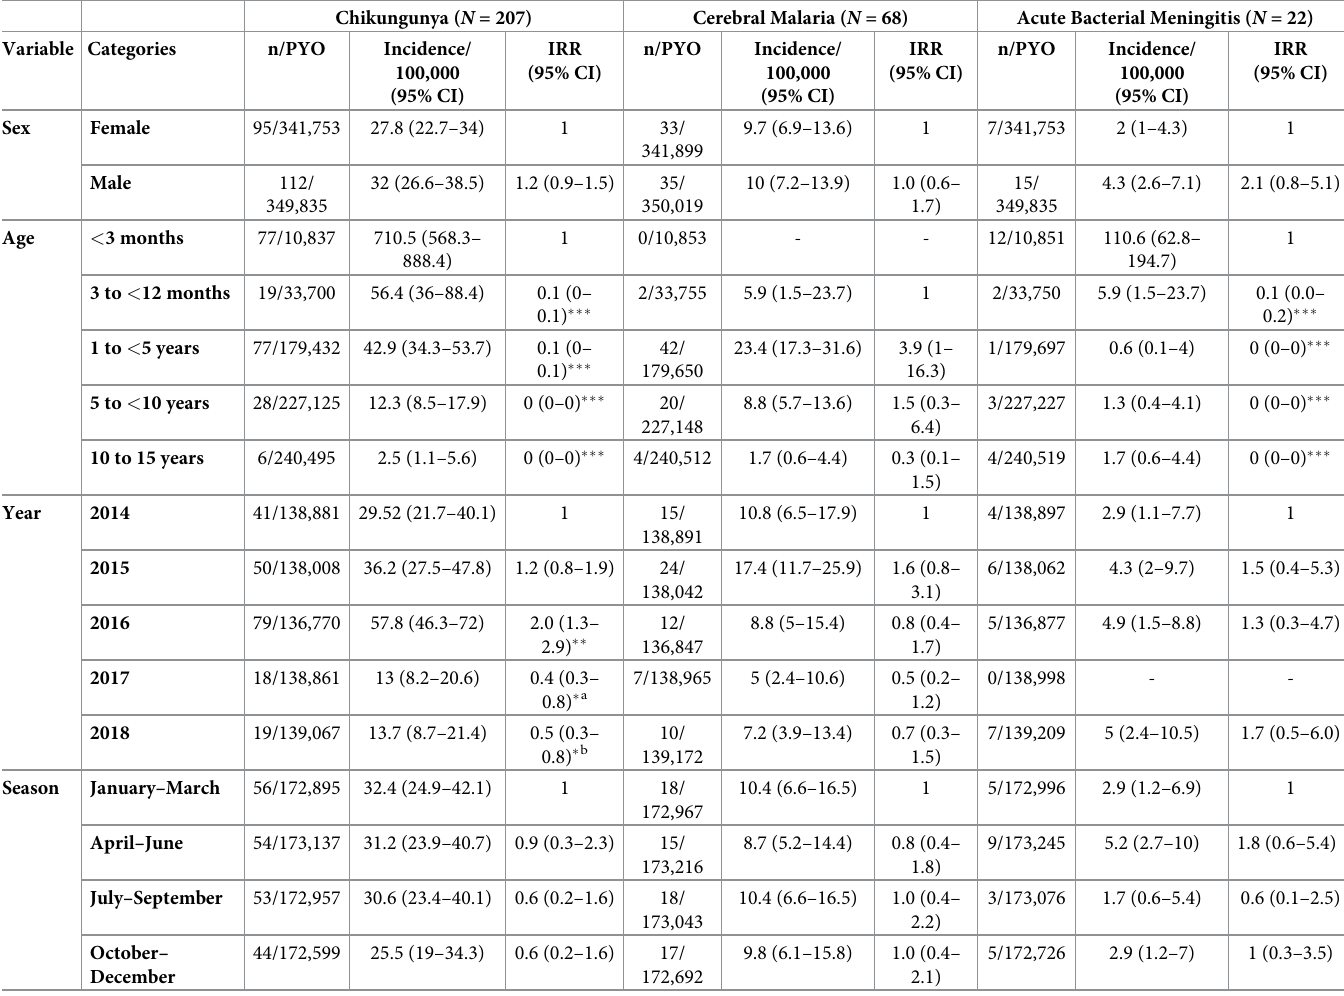
Table 2. Incidence of CHIKV-associated neurological disease among children aged < 16 years within the KHDSS during the study period